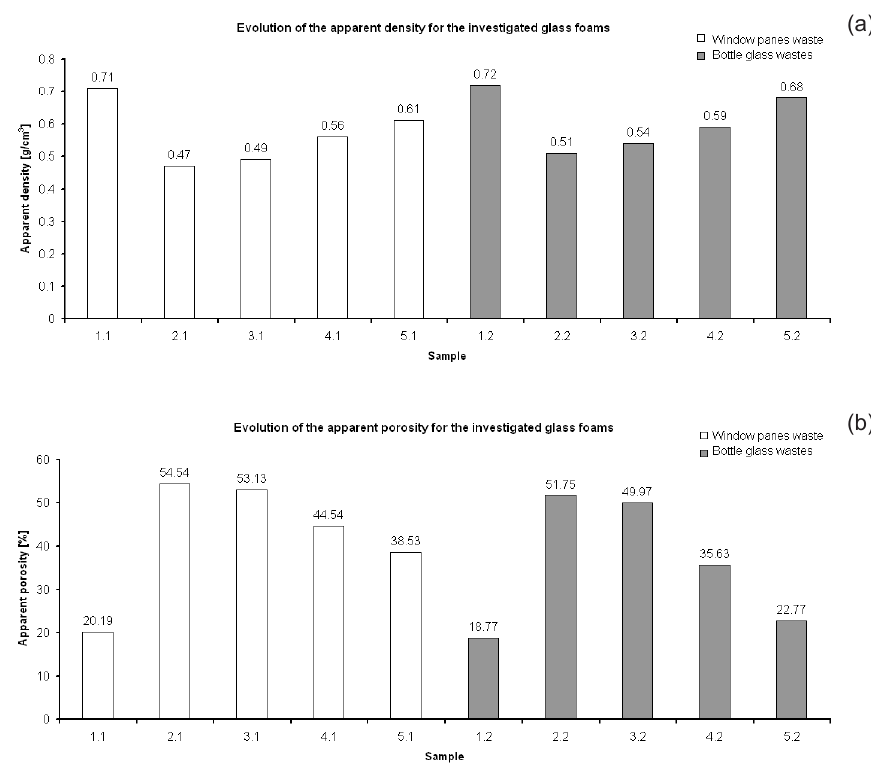
Figure 2. The apparent density and the apparent porosity of the studied glass foams.